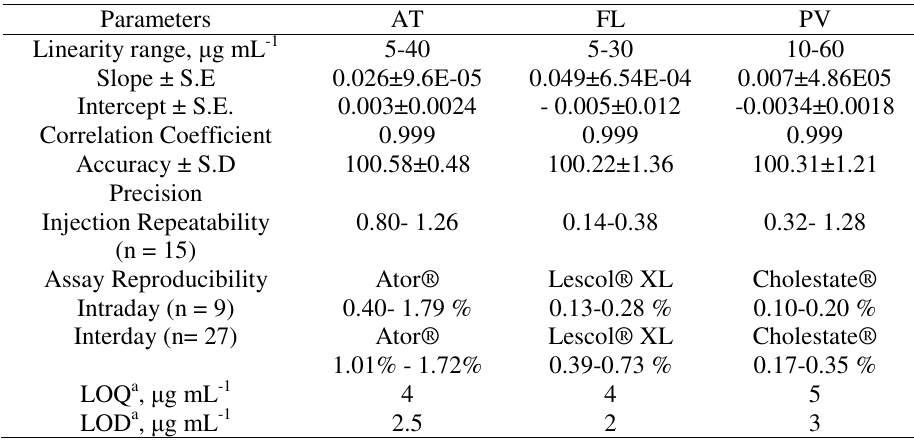
Table 1. Selected physical data for the determination of atorvastatin, fluvastatin and pravastatin by the proposed HPLC